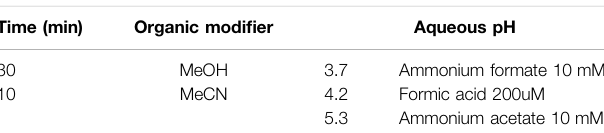
Table 2 , were used as the next critical factors during the